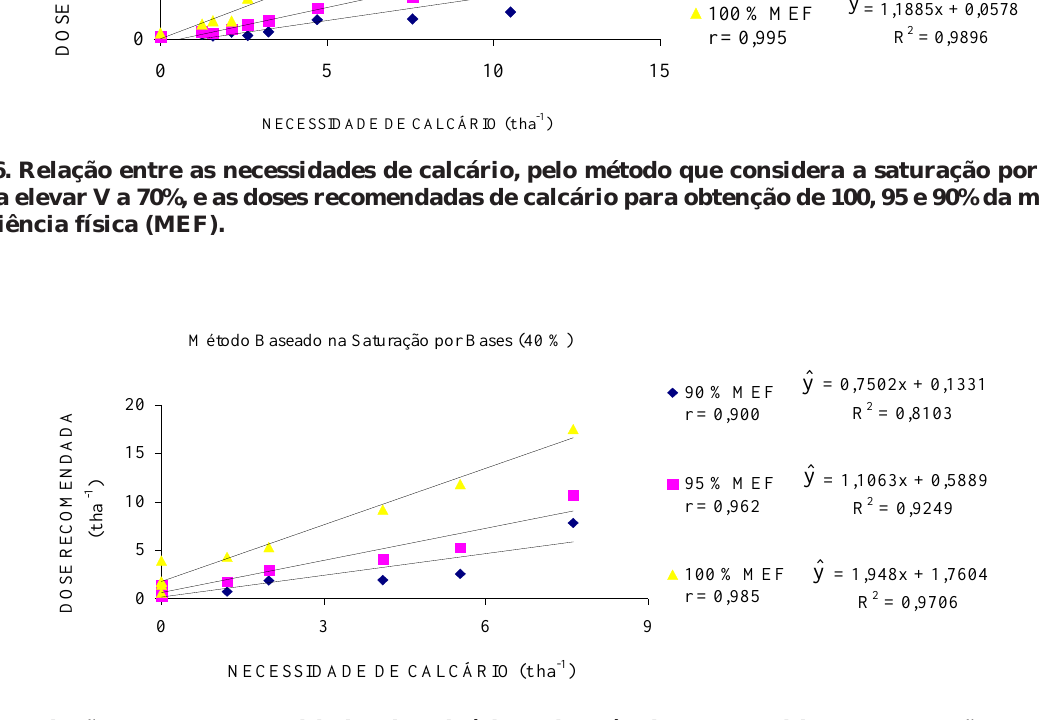
Figura 7. Relação entre as necessidades de calcário, pelo método que considera a saturação por bases para elevar V a 40%, e as doses recomendadas de calcário para obtenção de 100, 95 e 90% da máxima eficiência física